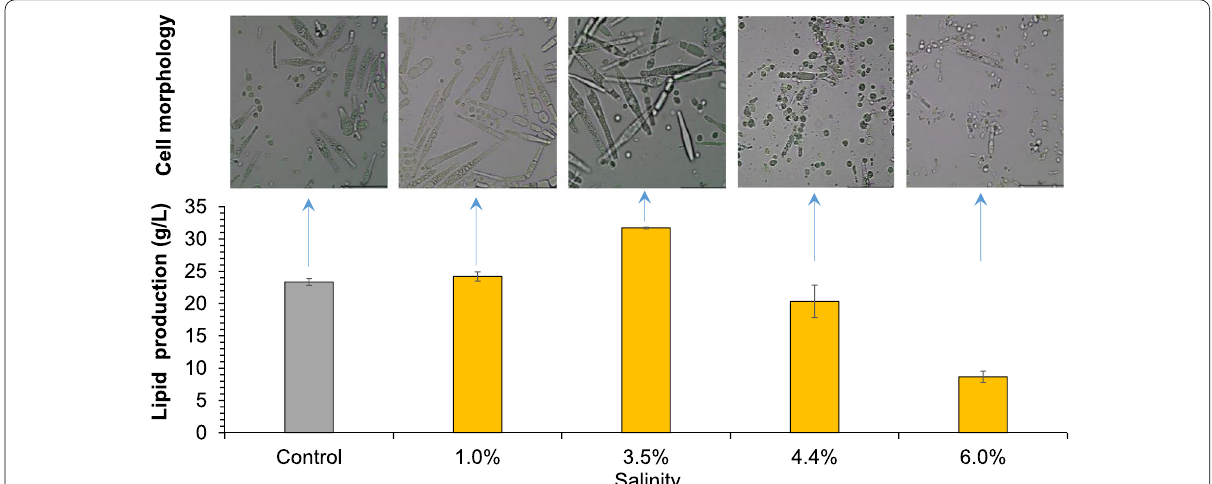
Fig. 4 Lipid production and cell morphology of T. cutaneum MP11 under different salinities. Lipid production was obtained at 96 h for the control,